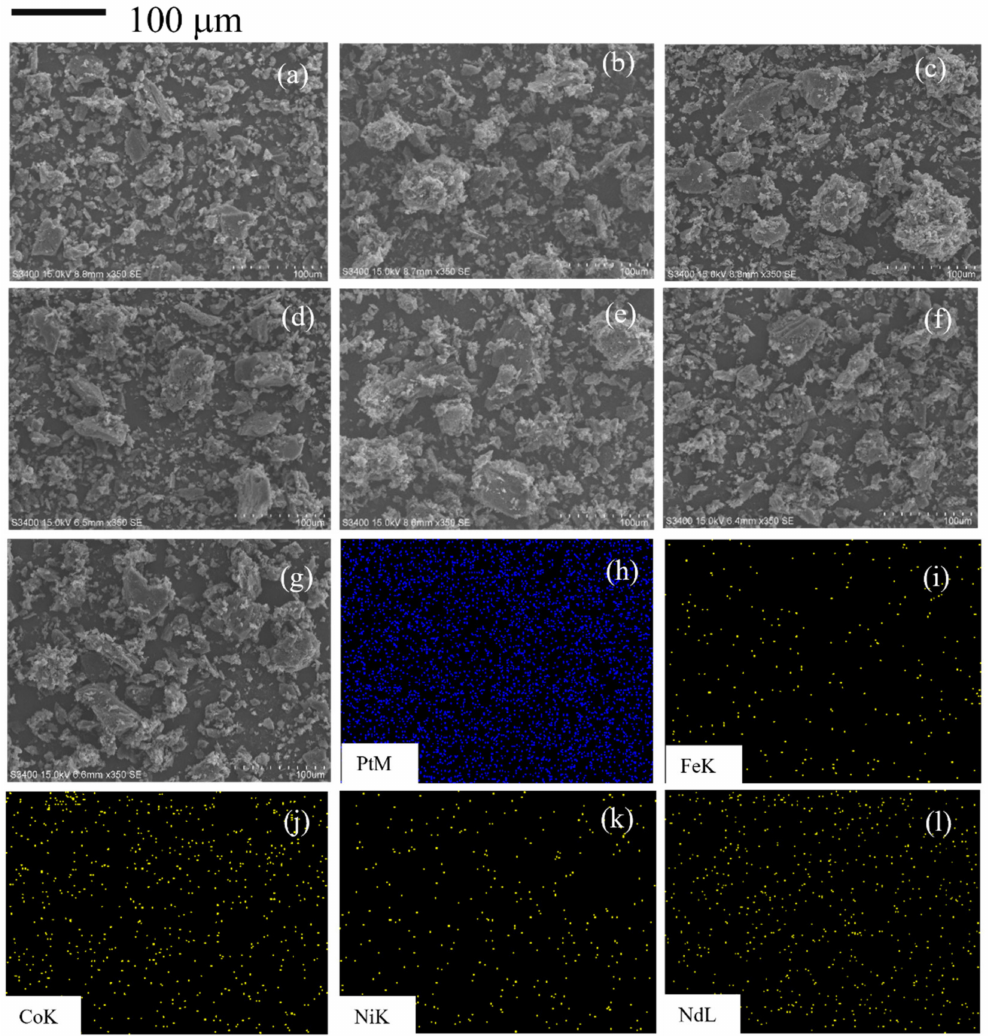
Figure 3. SEM images of ( a ) Pt/AC, ( b ) 0.15FePt/AC, ( c ) 5FePt/AC, ( d ) 10FePt/AC, ( e ) 0.15CoPt/AC, ( f ) 0.15NiPt/AC, and ( g ) 0.15NdPt/AC catalysts and the corresponding elemental mapping images of ( h ) platinum, ( i ) iron, ( j ) cobalt, ( k ) nickel, and ( l ) neodymium on 0.15MPt/AC. The magnetic properties were tested by using a simple external magnet to separate the catalyst from liquid media (Figure 4). The efficiency of the magnetic separation is highly dependent on the amount of ferromagnetic elements. The minimum %wt. of Fe loading on the Pt/AC to make the catalyst separable from the liquid by a magnet was determined to be 0.5 wt% Fe. The superior catalyst separation by magnet is demonstrated for higher Fe loadings such as 5% and 10% of Fe